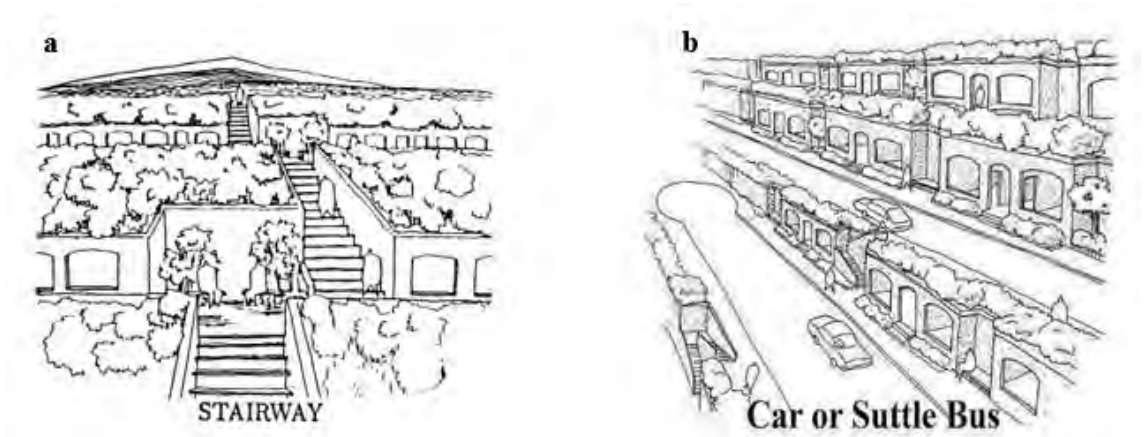
Figure 12. (a) Stairway for mild slopes; (b) Car or shuttle bus for steepslopes accessibility. (Golany and Ojima1996).